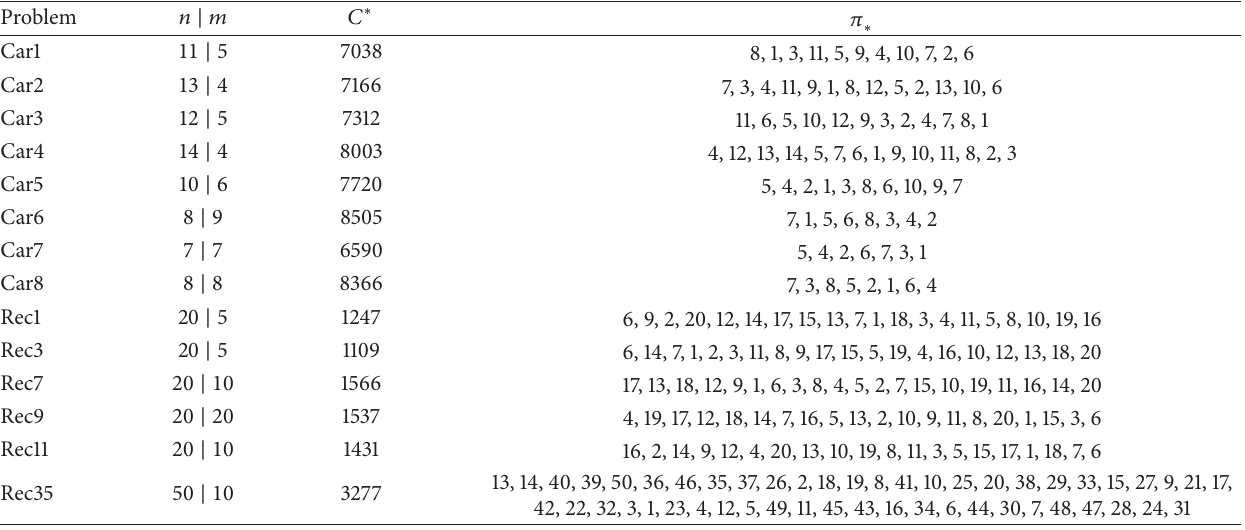
Table 3: Optimal job permutations of